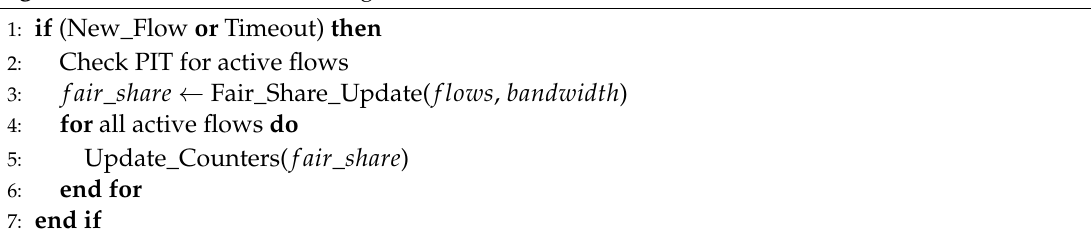
Algorithm 2 Per-flow data rate